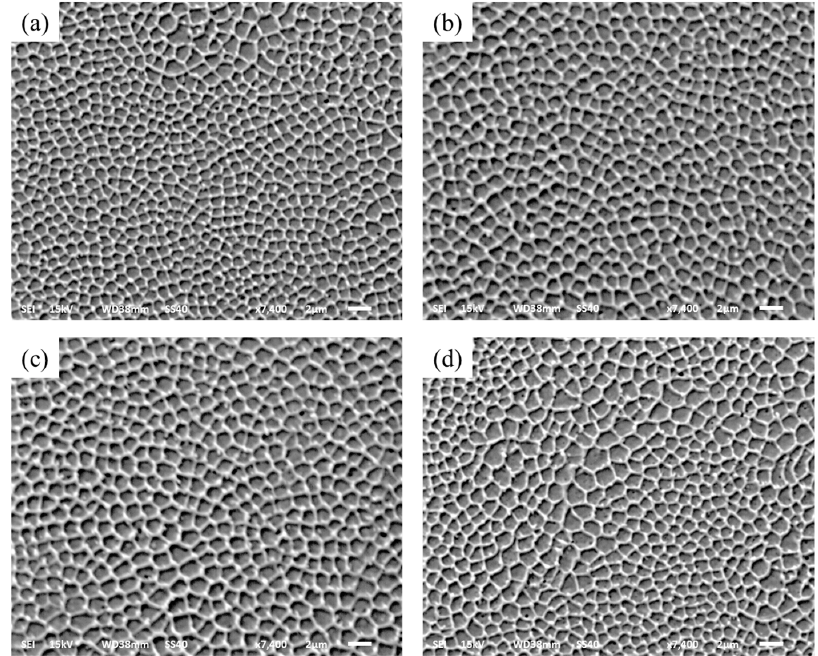
Figure 10. Microstructure of different exposure times ( a ) 80 μ s; ( b ) 120 μ s; ( c ) 160 μ s; ( d ) 200 μ s.